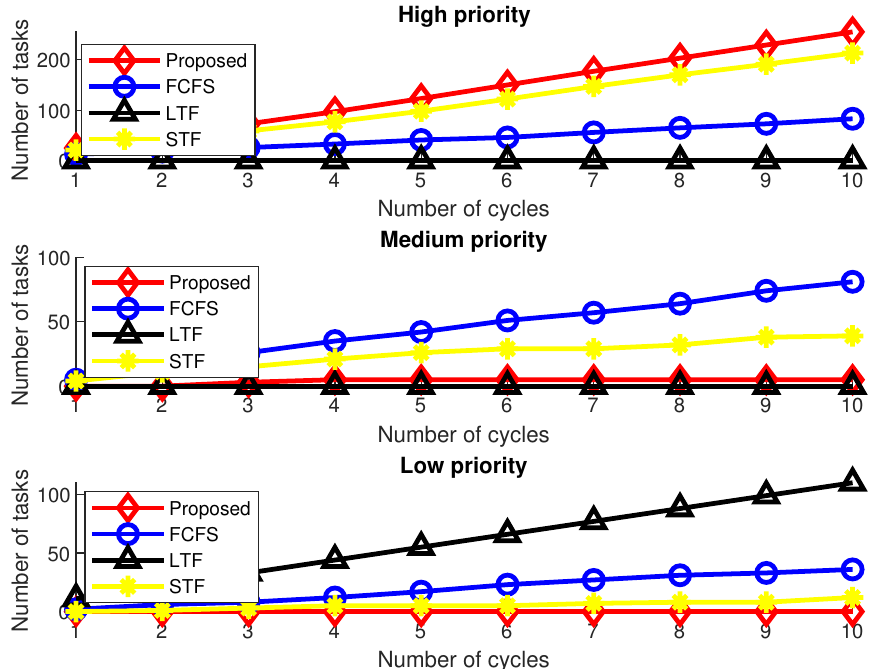
Figure 3. Number of tasks performed by fog nodes in different processing cycles.